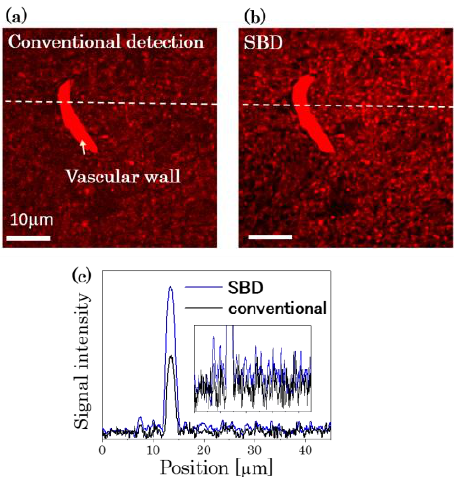
Figure 2. Improvement in the signal to noise ratio with the spatially segmented balanced detection: Phothothermal images of a slice of mouse bran ( a ) without and ( b ) with spatially segmented balanced detection (SBD). Pump beam power incident on the sample were 1 mW. The wavelengths of the pump and probe beam were 520 nm, and 640 nm, respectively. Image acquisition time was 6 s at 500 × 500 pixels. ( c ) Intensity profiles along the horizontal lines in ( a ) (black) and ( b ) (blue).